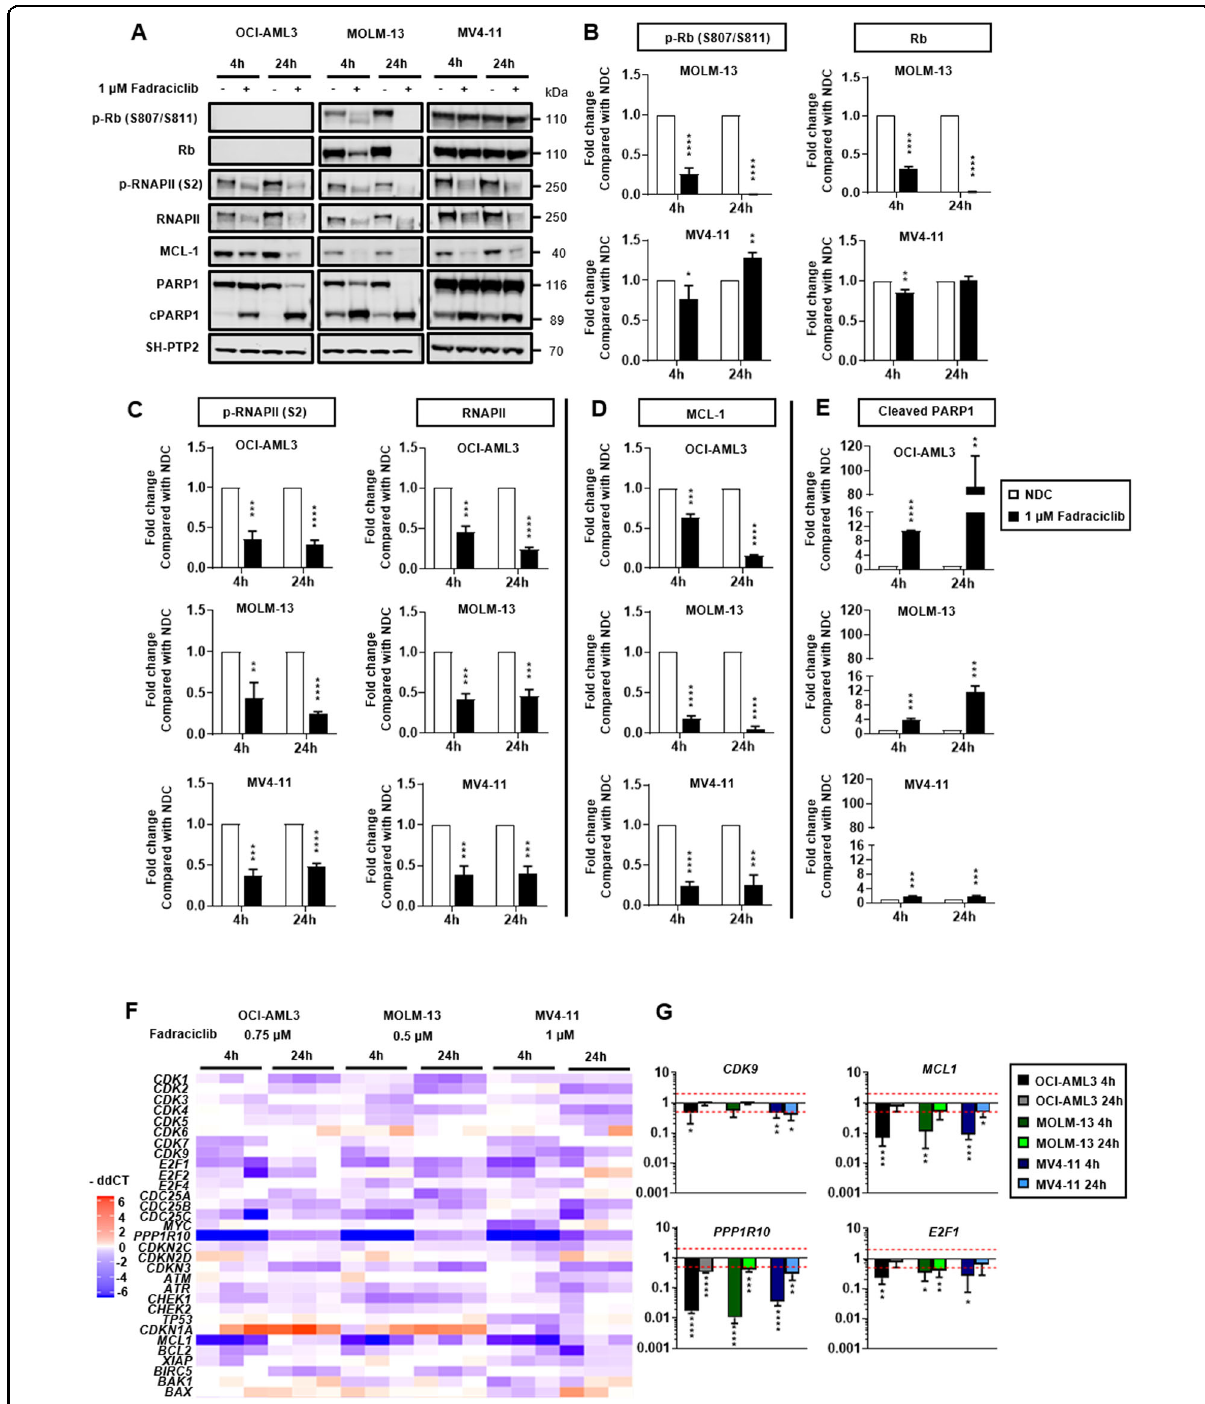
Fig. 2 Fadraciclib downregulates MCL-1, resulting in rapid induction of apoptosis in lines treated with 1 µM of fadraciclib for 4 and 24 h. SH-PTP2 was used as an internal AML cell lines. A Representative Western blot of OCI-AML3, MOLM-13, and MV4-11 cell protein loading control. B Densitometric analysis of serine 807/serine 811 (S807/S811) phosphorylated and total Rb. C Densitometric analysis of serine 2 (S2) phosphorylated RNAPII and total RNAPII. D Densitometric analysis of MCL-1. E Densitometric analysis of cleaved poly (ADP-ribose) polymerase-1 (PARP1). F Heatmap demonstrating fold changes relative to NDC of gene expression of OCI-AML3, MOLM-13, and MV4-11 cell lines treated with 0.75, 0.5, and 1 µM of fadraciclib, respectively, for 4 and 24 h. G Fold changes of CDK9 , MCL1 , PPP1R10 , and E2F1 gene expression as compared with NDC. n = 3. Graphs depict mean ± SD (* p < 0.05, ** p < 0.01, *** p < 0.001, **** p < 0.0001). Data were compared using the Student ’ s t